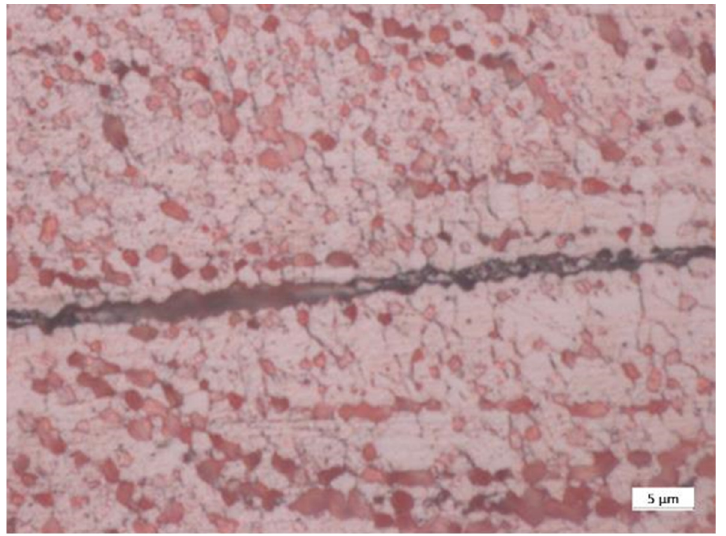
Figure 10. Detail of the grain size of copper next to the contact line of the diffusion-bonded surfaces after the chemical etching.